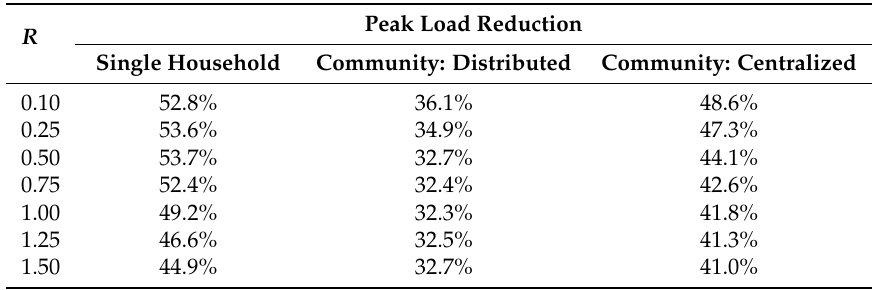
Table 3. Peak load reduction with different production-to-consumption ratios R in a single household and on the community level with both distributed and centralized charging approaches. Peak Load Reduction R Single Household Community: Distributed Community: